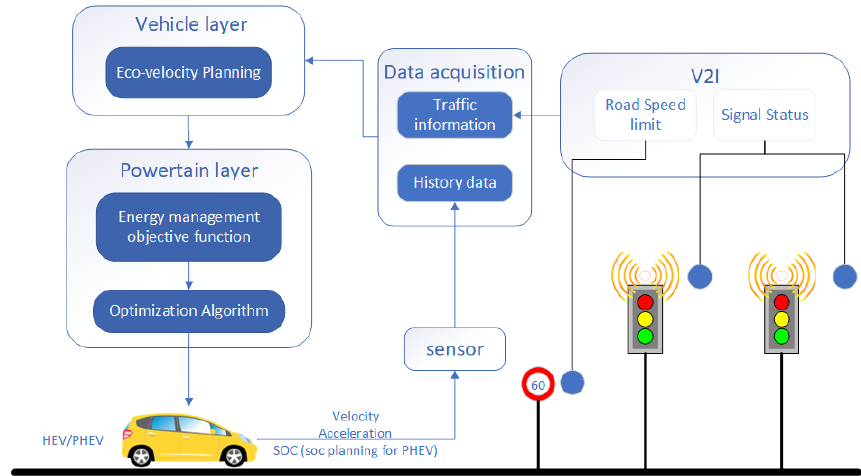
Figure 8. The Scenario of single-vehicle cooperative optimization logic based on V2I